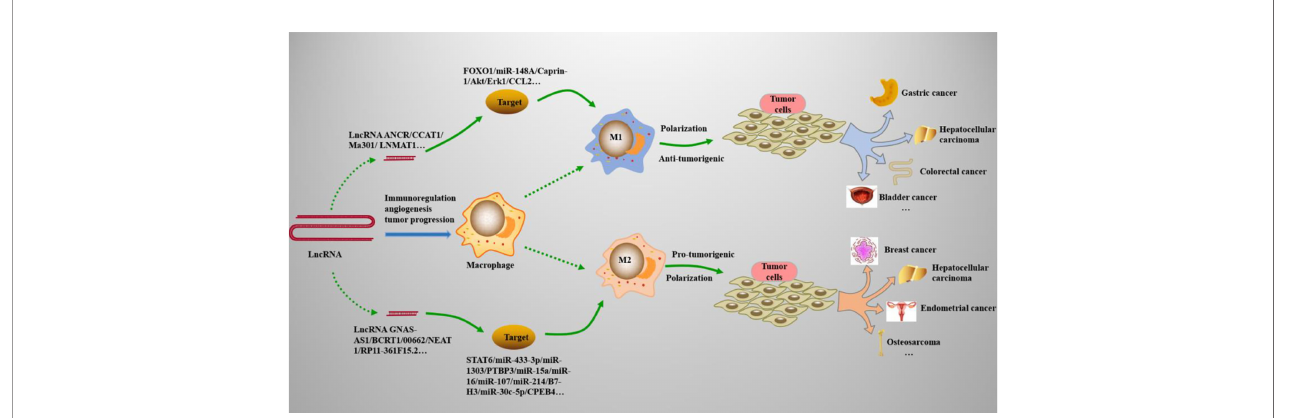
FIGURE 2 | LncRNAs regulate M j s polarization in cancers. Many types of lncRNAs play important roles in cancers by acting on the M1 and M2 polarization processes of M j s . (1) M1 polarization can resist tumor cells and play an immunomodulatory role in tumor microenvironments, such as gastric cancer, bladder cancer, and colorectal cancer. (2) M2 polarization promotes the growth, migration, and proliferation of tumor cells, and is involved in the progression of cancers, such as breast cancer, hepatocellular carcinoma, and